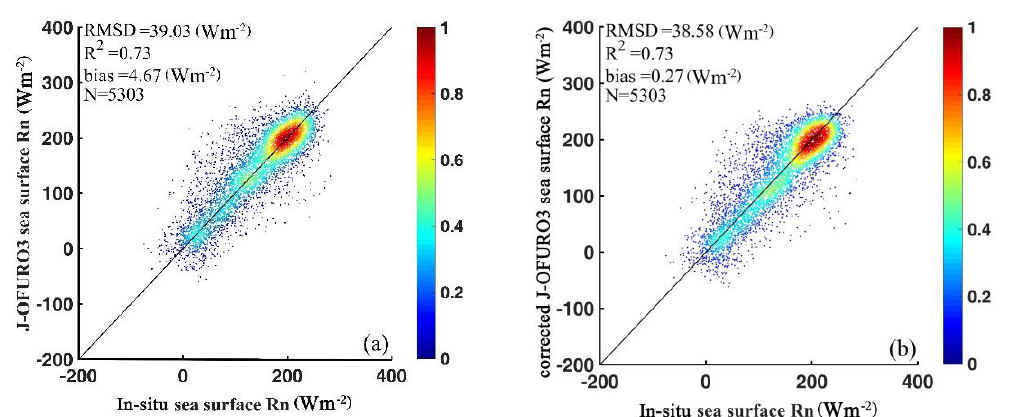
Figure 12. Scatter plots between the J-OFURO3 daily sea-surface R n and the in situ R n , from 1988 to 2000, before ( a ) and after ( b ) inconsistency correction.